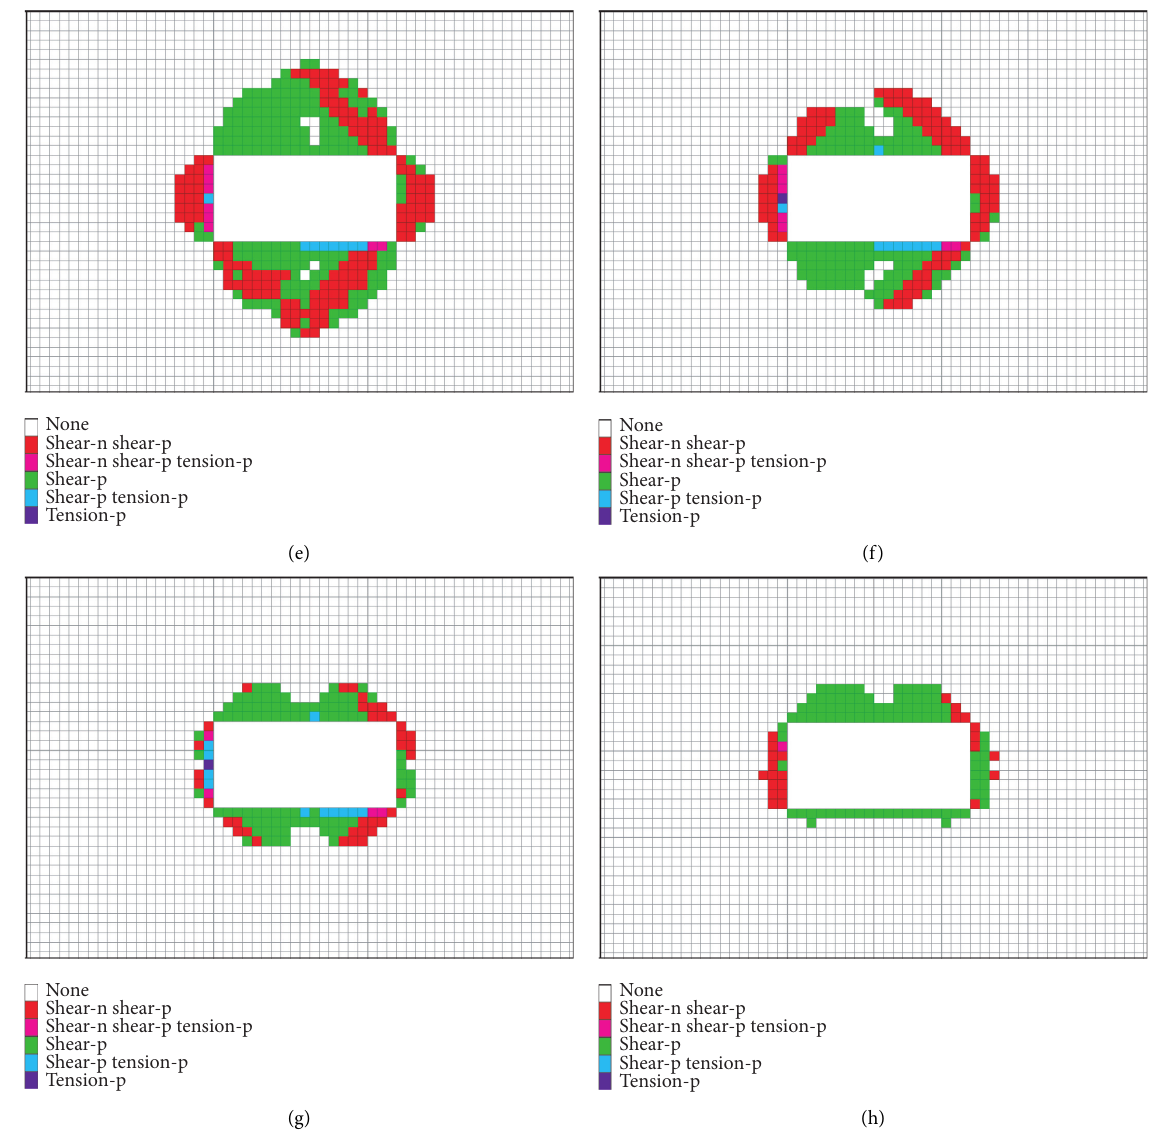
Figure 10: The distribution of plastic zone in different lithologies. (a) C � 0.6, Φ � 25 ° , (b) C � 0.9, Φ � 25 ° , (c) C � 1.2, Φ � 25 ° , (d) C � 1.5,